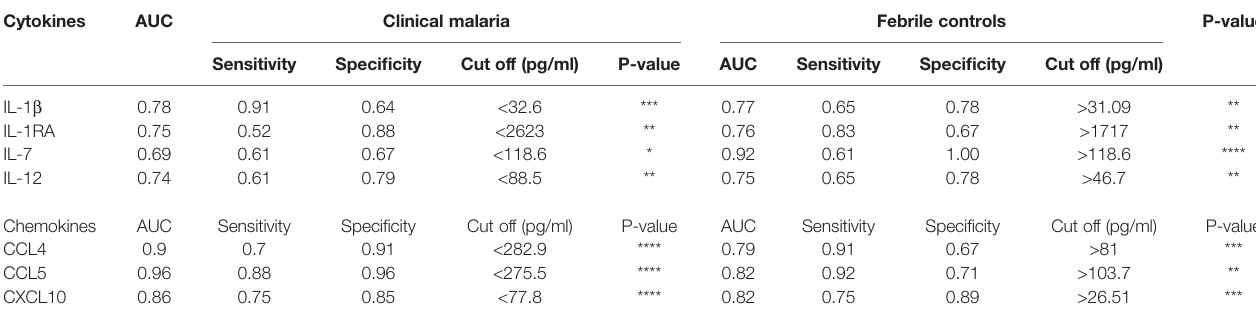
showing the greatest potential with an AUC value of 0.96. For distinguishing between sepsis from febrile controls, both CCL5 (0.82, p<0.01) and CXCL10 (0.82, p<0.001) showed the greatest potential in differentiating the two groups.